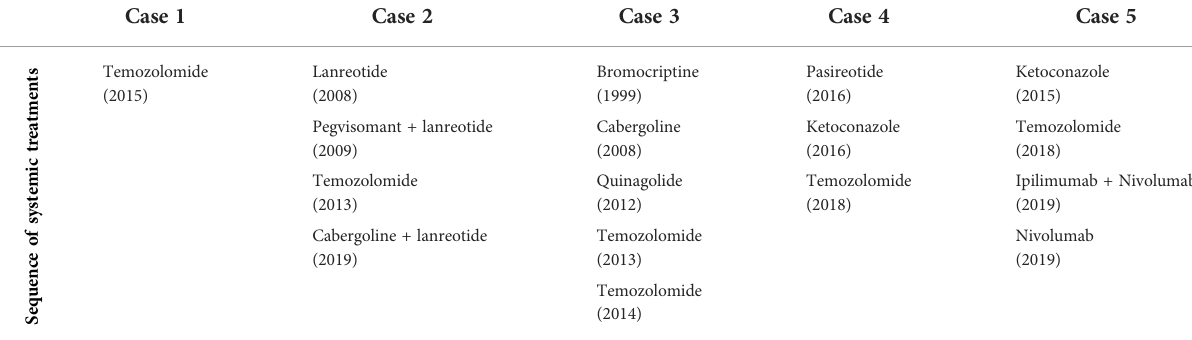
TABLE 2 Overview of systemic treatment per